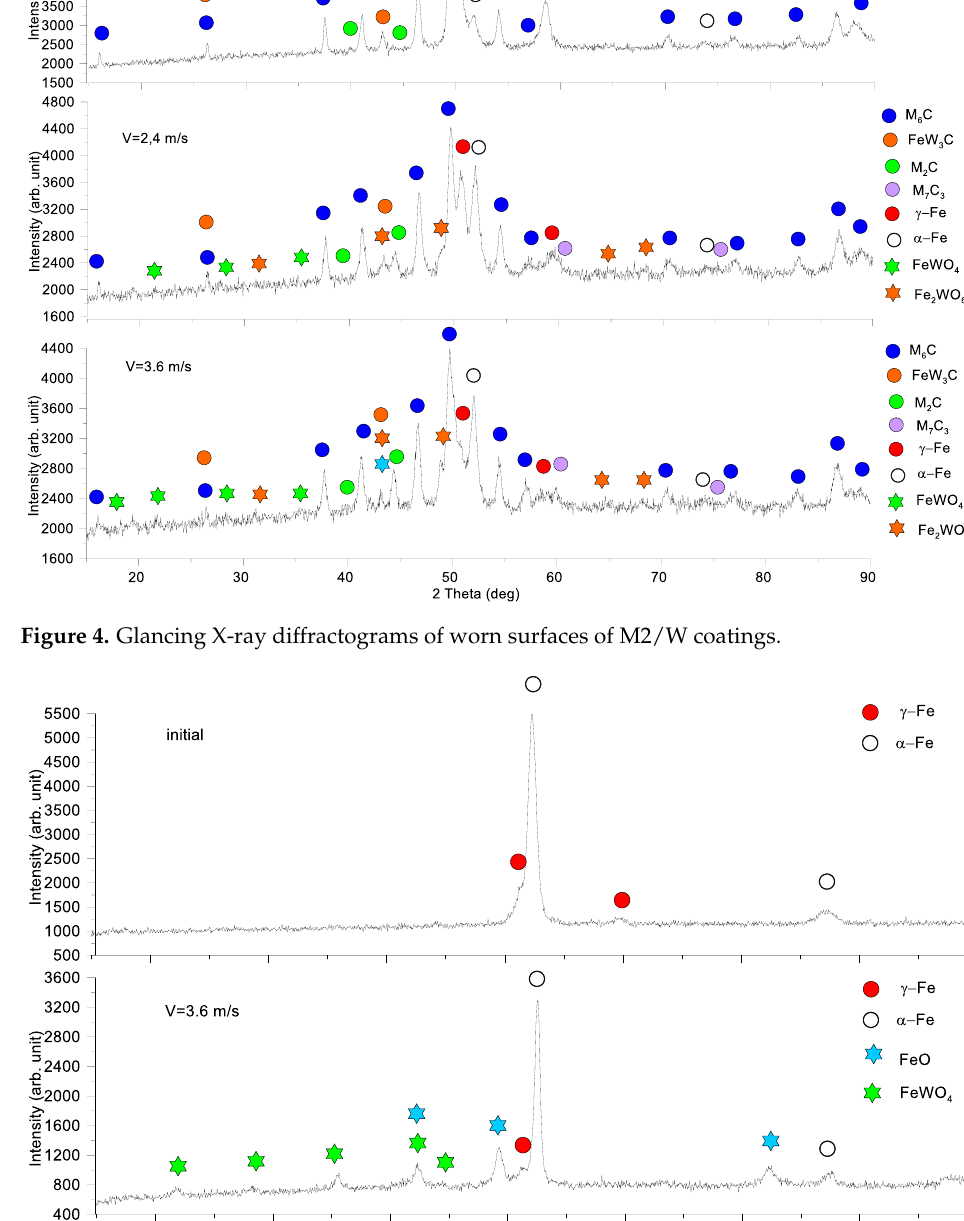
Figure 5. Glancing X-ray diffractograms of initial and worn surface of AISI 52,100 counterbody with incidence angle 5°. Data presented for specimens after sliding speed of 3.6 m/s.